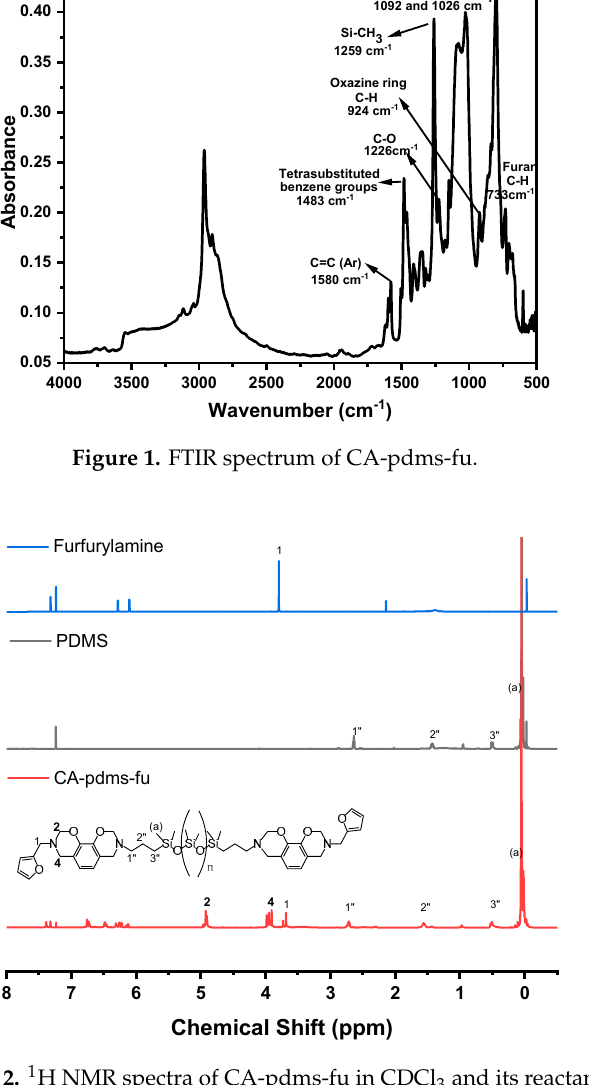
Figure 1. FTIR spectrum of CA-pdms-fu.